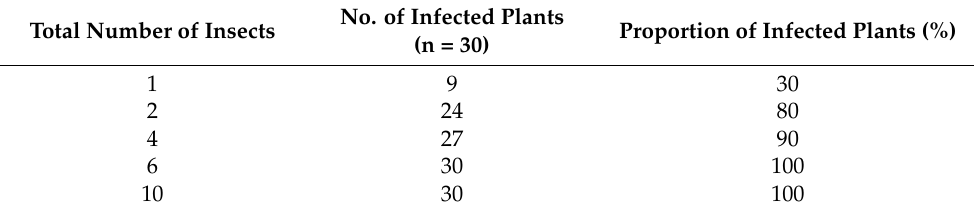
Table 3. Viral transmission frequencies from different numbers of